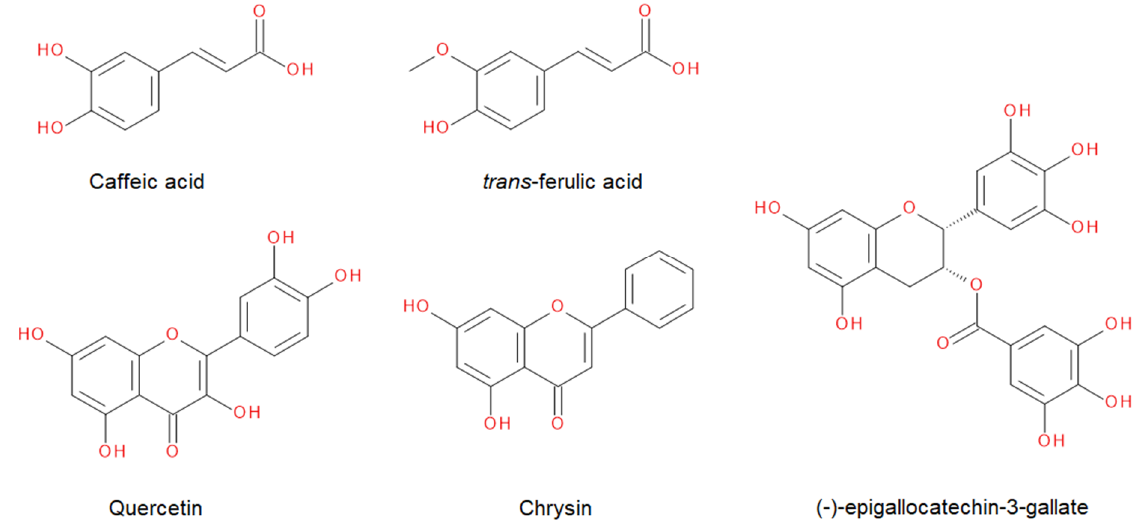
Figure 3. Chemical structures of isolated compounds from different propolis samples.